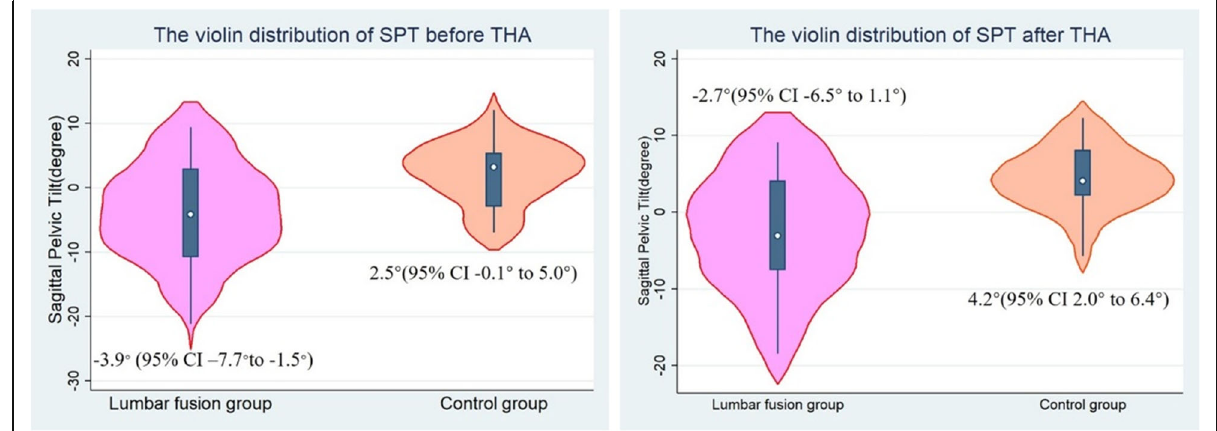
Fig. 2 The violin plot of SPT showing that the mean SPT was significantly less both before and after THA in the lumbar fusion group, which indicates a relatively posterior